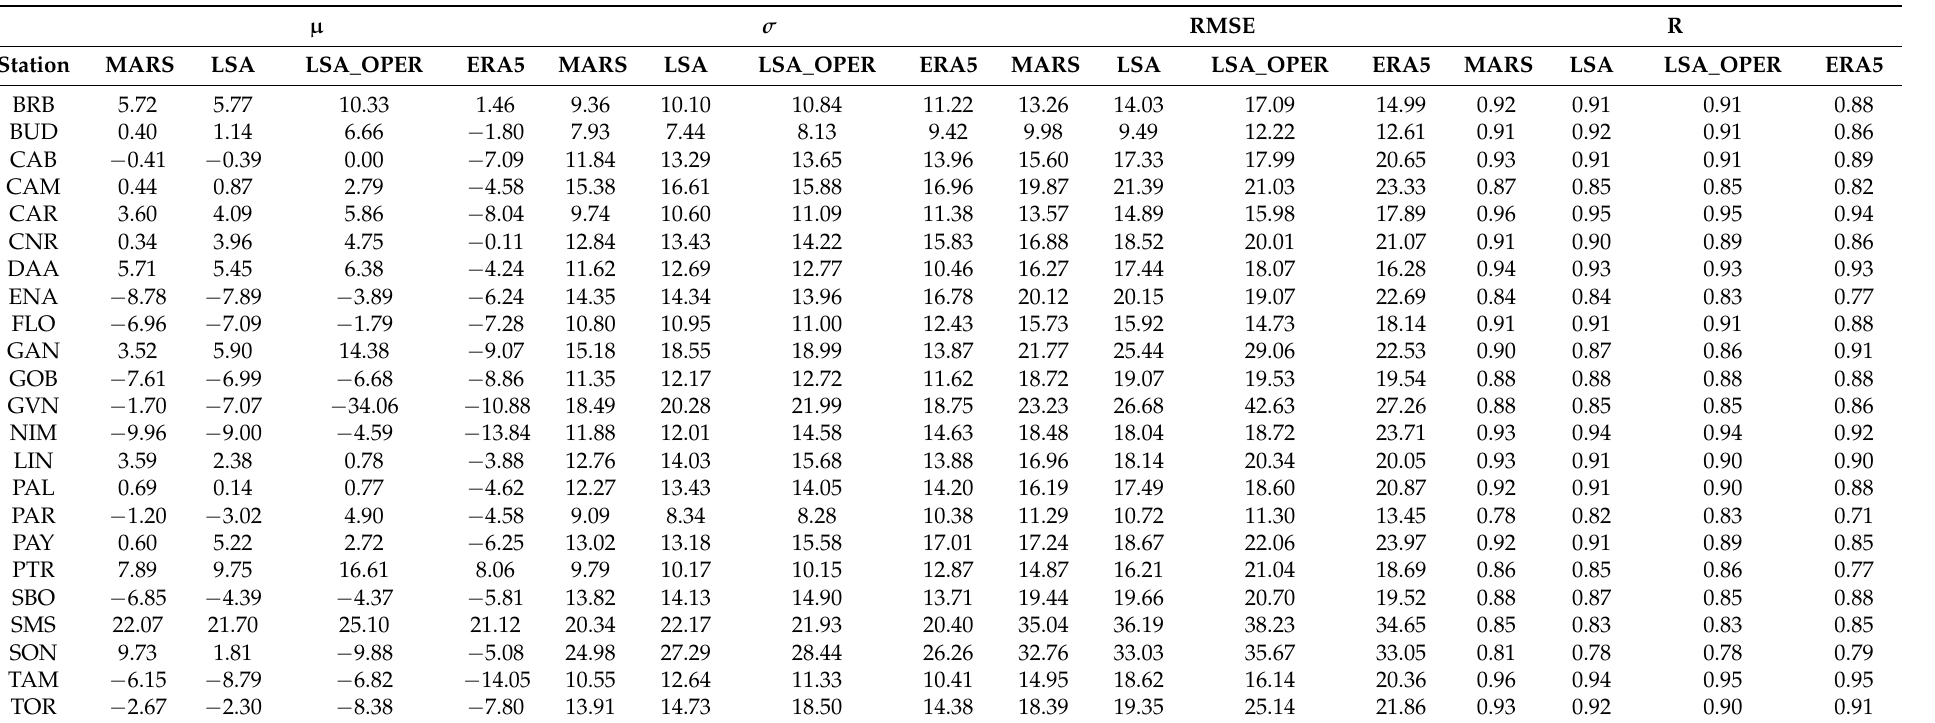
Table A5. Error metrics between model (MARS, LSA_OPER, LSA, and ERA5) and measuring station (all-sky conditions) for 2004–2019. Bias ( µ ), standard deviation